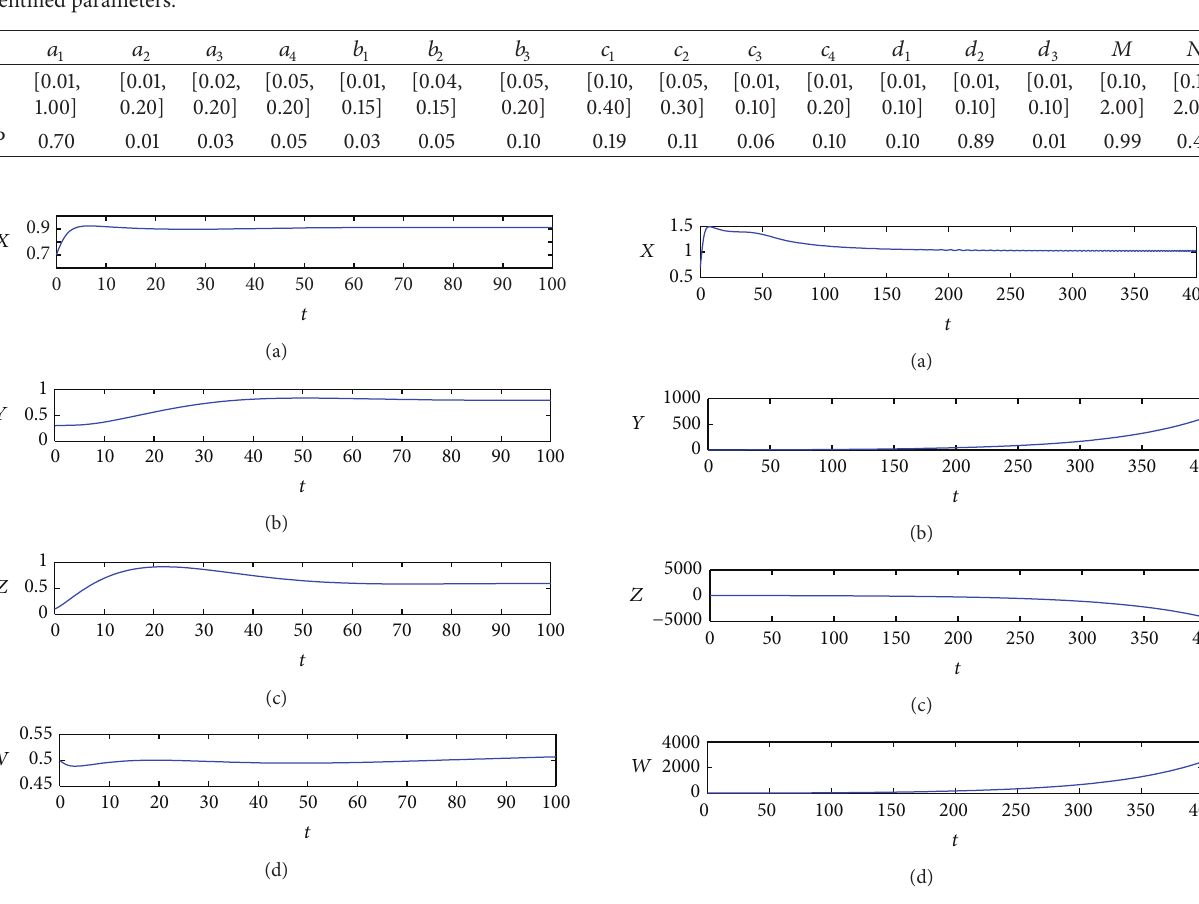
to ensure the steady development of the water resources sup- ply-demand system.